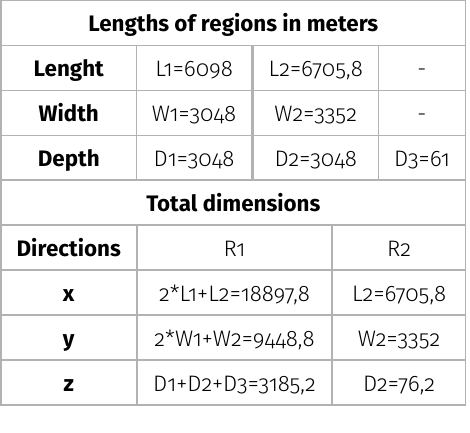
Table I. Geometric parameters of the model, dimensions are in meters.